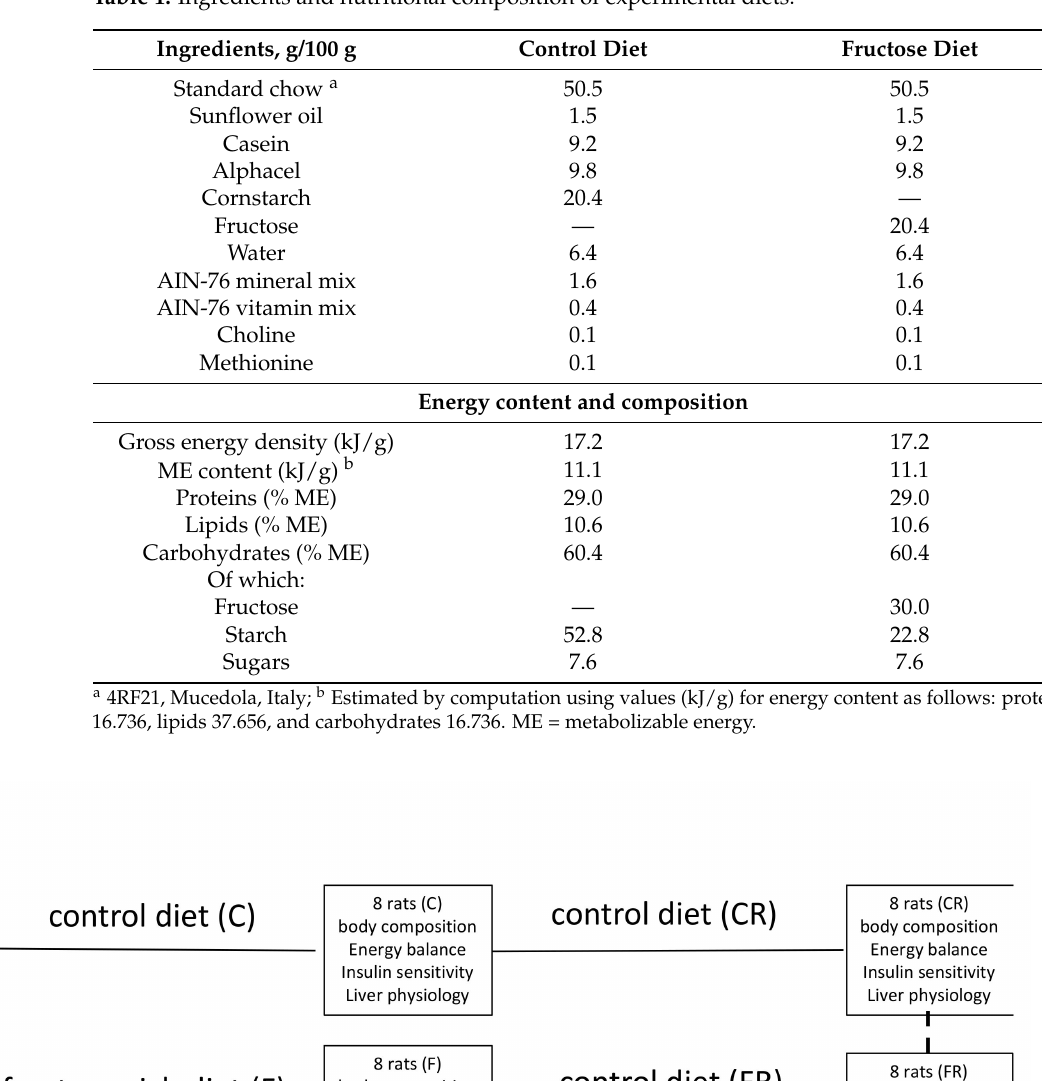
Table 1. Ingredients and nutritional composition of experimental diets.